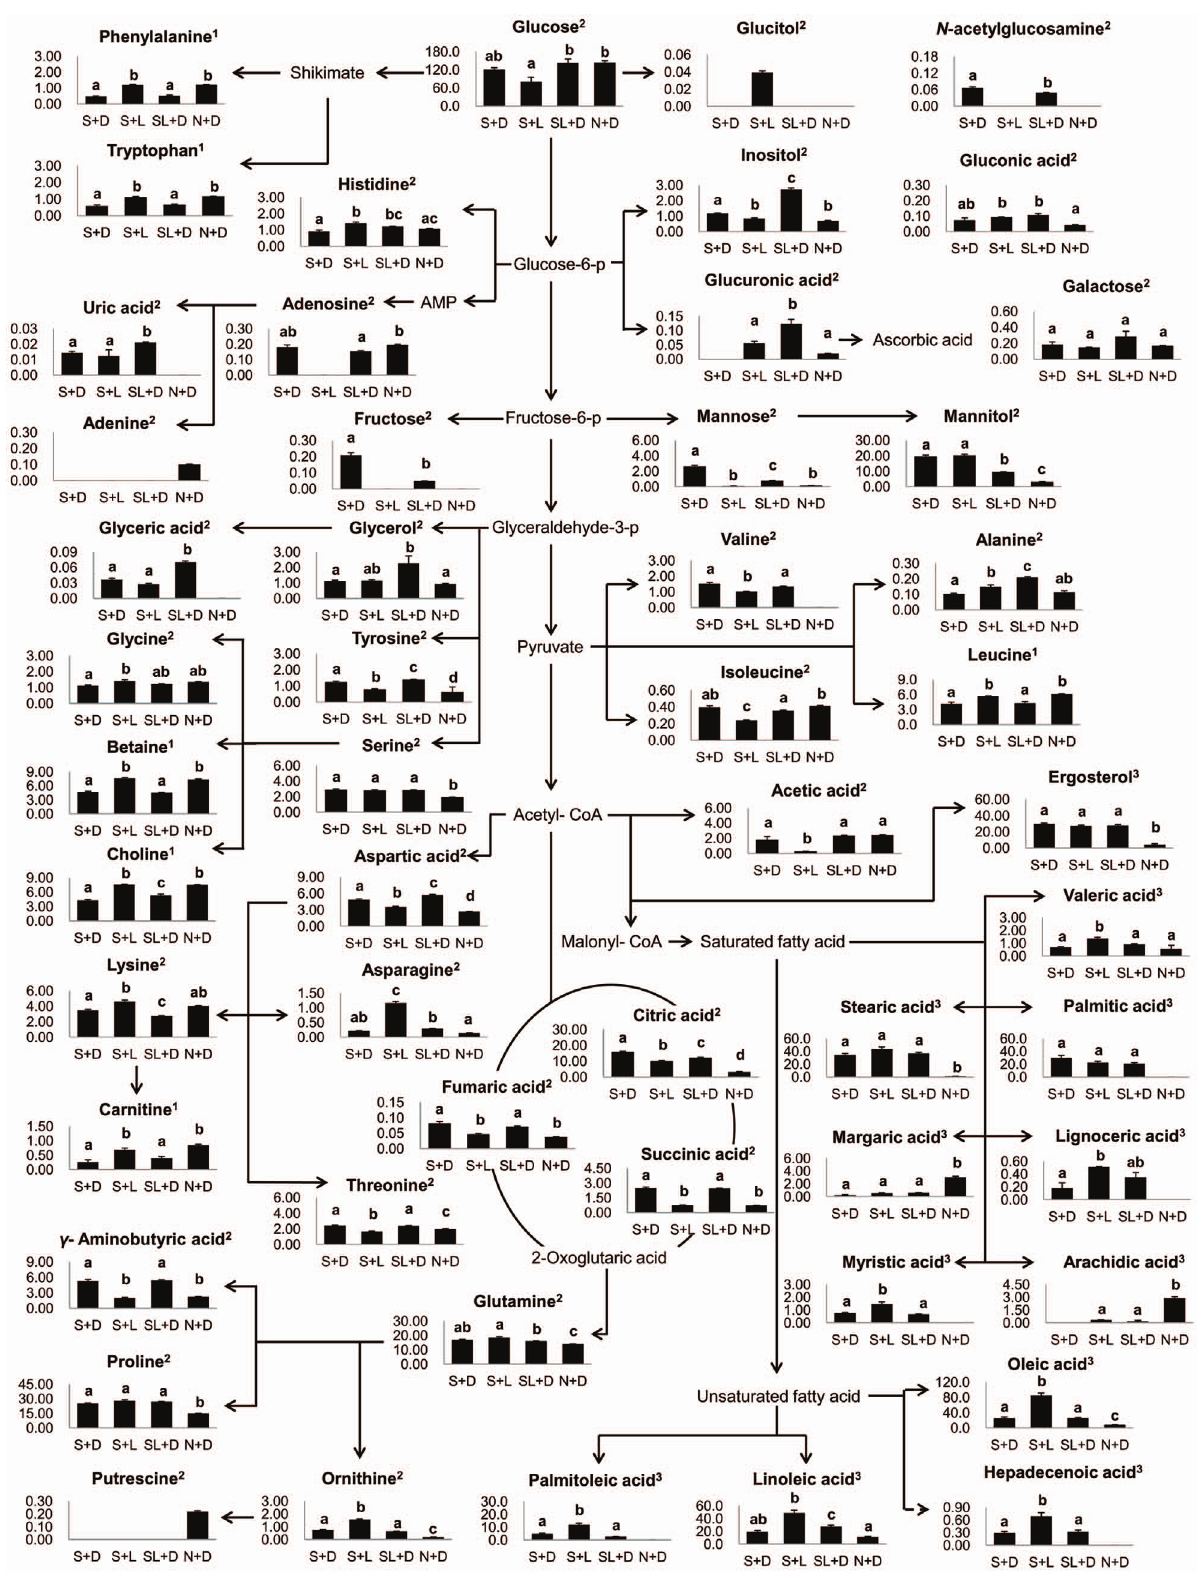
Figure 4. Schematic diagram of the metabolic pathway and relative levels of the major compounds detected in C. pruinosa extracted with 70% MeOH and 100% n- hexane plus D 2 O. This was modified from pathways presented in KEGG database (http://www. genome.jp/kegg/). ANOVA was performed to assess the statistical significance of differences between samples (p , 0.05). Data are mean values with error bars representing standard deviation values. Different letters in bars represent the difference of statistical significance of metabolites levels. The